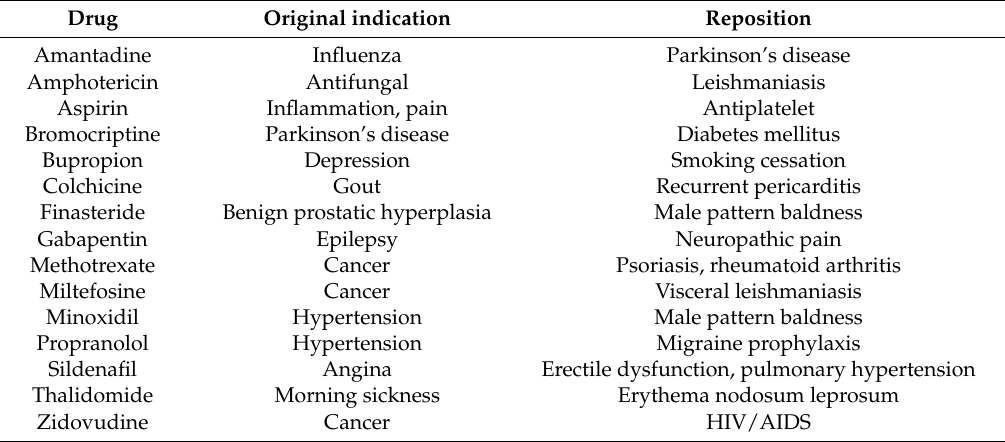
Table 1. Examples of successfully repositioned